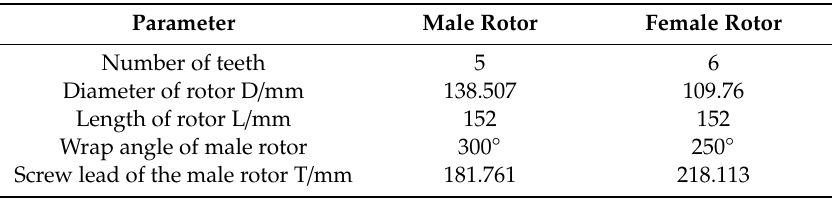
Table 3. Structural parameters of the screw compressor.